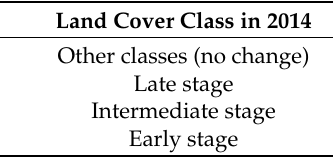
Figure 4. Reflectance signature of the three successional stages of TDF for 2008 and 2014, after inverted PCA. Mean value (solid line) and standard deviation (dashed line). 3. Results The succession maps for 2008 and 2014 were evaluated using confusion matrices (Table 5). The highest overall classification accuracy was achieved with SVM (64.5% in 2008; 80.5% in 2014) while the lowest accuracies were obtained using the DT classifier (61.2% for 2008) SAM (68.9% for 2014) (Table 5). If we consider the kappa accuracy instead, lowest values are for the DT (0.49 in 2008) and SAM (0.60 in 2014) (Table 5). All overall map accuracies are above 60% (Table 5). These values are acceptable, considering that the spectral signature of the three successional stages are very similar, especially between intermediate and late stages (Figure 4). The statistical separation of classes in a classification depends on the spectral separability of the succession classes. Given that tropical dry